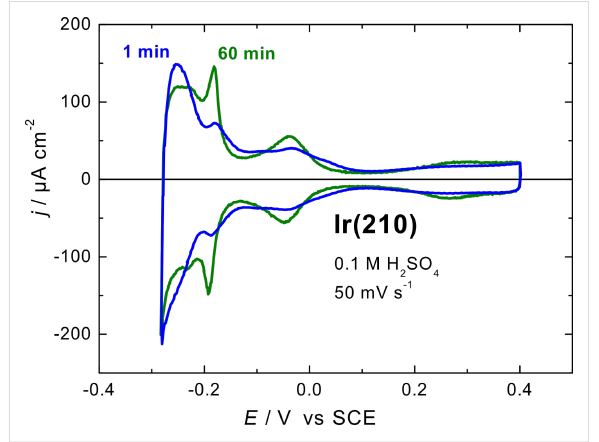
− 0.25 V. The noticeable increase in the former two peaks (at − 0.18 and − 0.04 V) indicates the possible formation of (311) facets [20], because the peak at − 0.18 V is characteristic of Ir(311) [5].